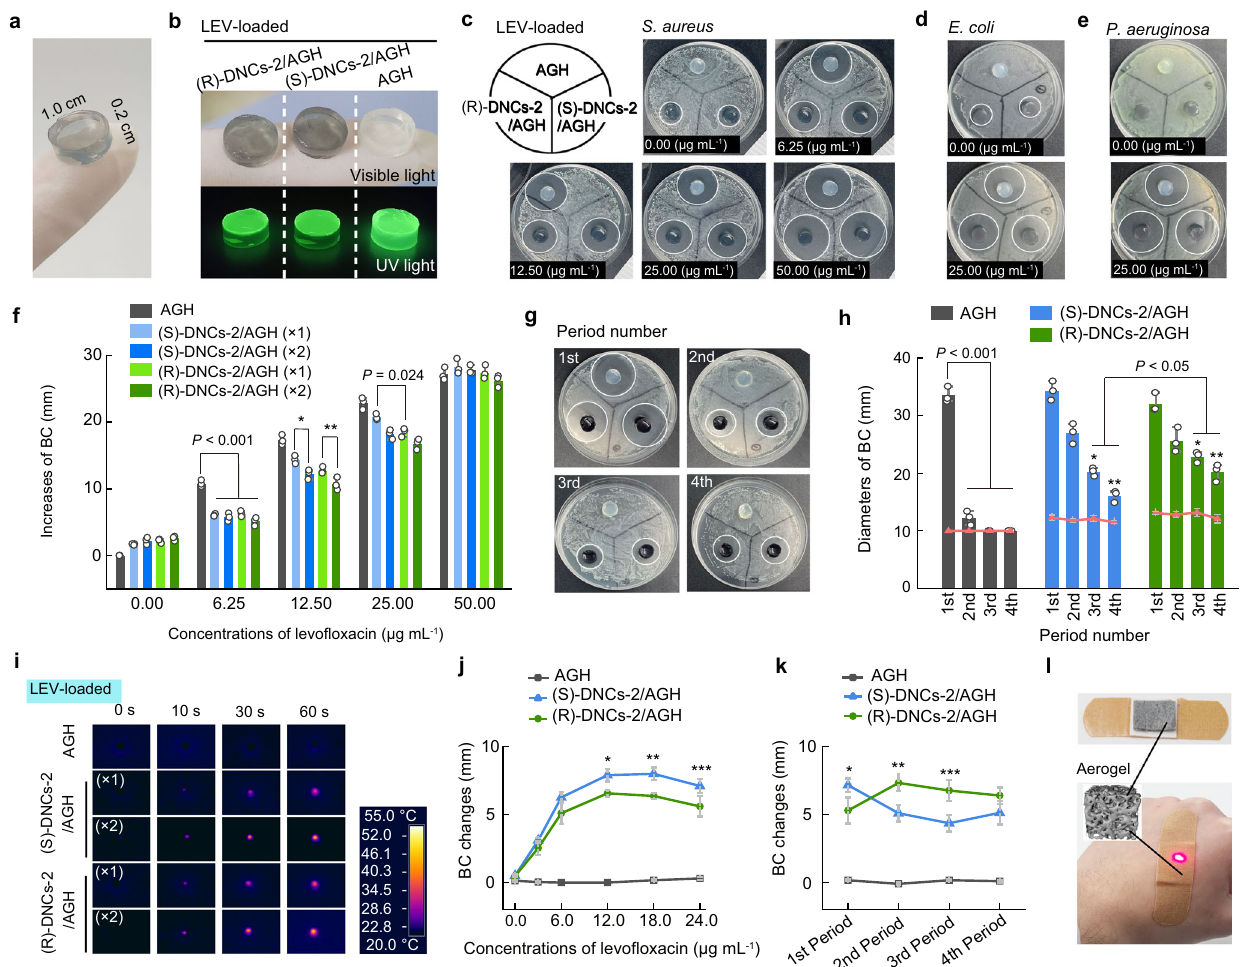
Fig.6|Enantioselective,IR-activated,andsustainableantimicrobialhydrogels. a Photograph of a nanostructure-doped hydrogel tablet. b Photos showing levo fl oxacin-loaded hydrogel tablets without and with doping of (R)-DNCs-2 and (S)-DNCs-2 under irradiation with visible and UV light. c – e Photos indicating the bacteriostaticcircles(BC)of S.aureus ( c ), E.coli ( d ),and P.aeruginosa ( e )fortablets loadedwithvariousconcentrationsoflevo fl oxacin( c 0.00-50.00 μ gmL − 1 ; d , e 0.00 and 25.00 μ gmL − 1 ). f Statistical BC results for different tablets loaded with various concentrations of levo fl oxacin. The concentrations of the nanostructures were 100 μ gmL − 1 (×1) and 200 μ gmL − 1 (×2). * P =0.035, ** P =0.024; the signi fi cant differ- encebetweenBCincreasesoflevo fl oxacin-loaded(S)-DNCs-2/AGHand(R)-DNCs-2/ AGH. g , h Pictures ( g ) and statistical results ( h ) indicating sustainable release per- formance based on the period-dependent BCs of diverse levo fl oxacin-loaded hydrogel tablets. The red curves in h show the BCs of hydrogel tablets without levo fl oxacin. * P =0.008, ** P =0.007; signi fi cant difference between levo fl oxacin- loaded (S)-DNCs-2/AGH and (R)-DNCs-2/AGH in the 3rd and 4th periods of sus- tained antimicrobial experiments. i Diverse tablets irradiated with IR light for a